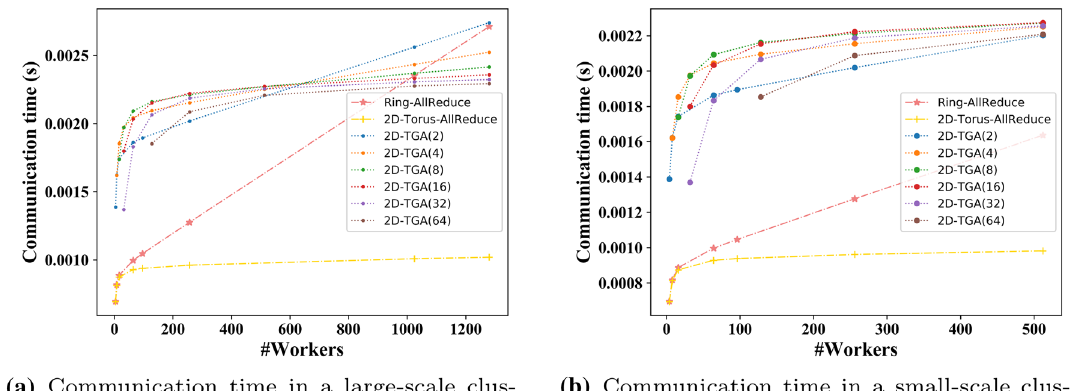
Fig. 4 Communication time of 2D-TGA algorithm in different